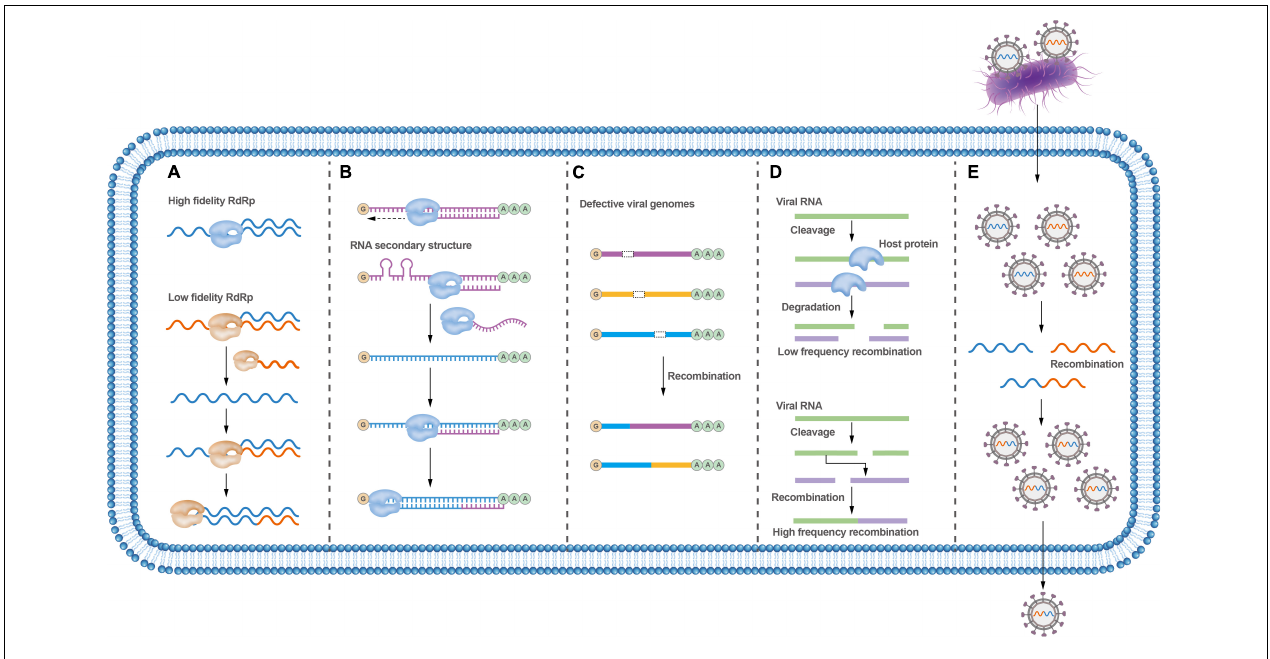
FIGURE 3 | Factors that affect RNA virus recombination. (A) RdRp fidelity affects the recombination rate; low-fidelity RdRp variants are more prone to recombination. (B) Secondary RNA structures between distinct viruses may block strand-switching and lead to virus recombination. (C) Defective viruses can undergo recombination to exchange gene fragments to require the whole viral genome; viruses can recombine with unrelated viral genes or cellular genes. (D) Host proteins may influence virus recombination. (E) Bacteria can carry viruses during co-infection, thus facilitating virus